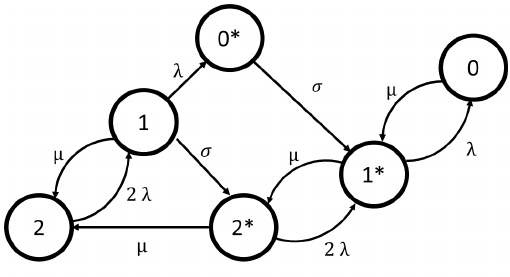
Figure 16. CTMC model for the UPS cold standby system (UPS system).